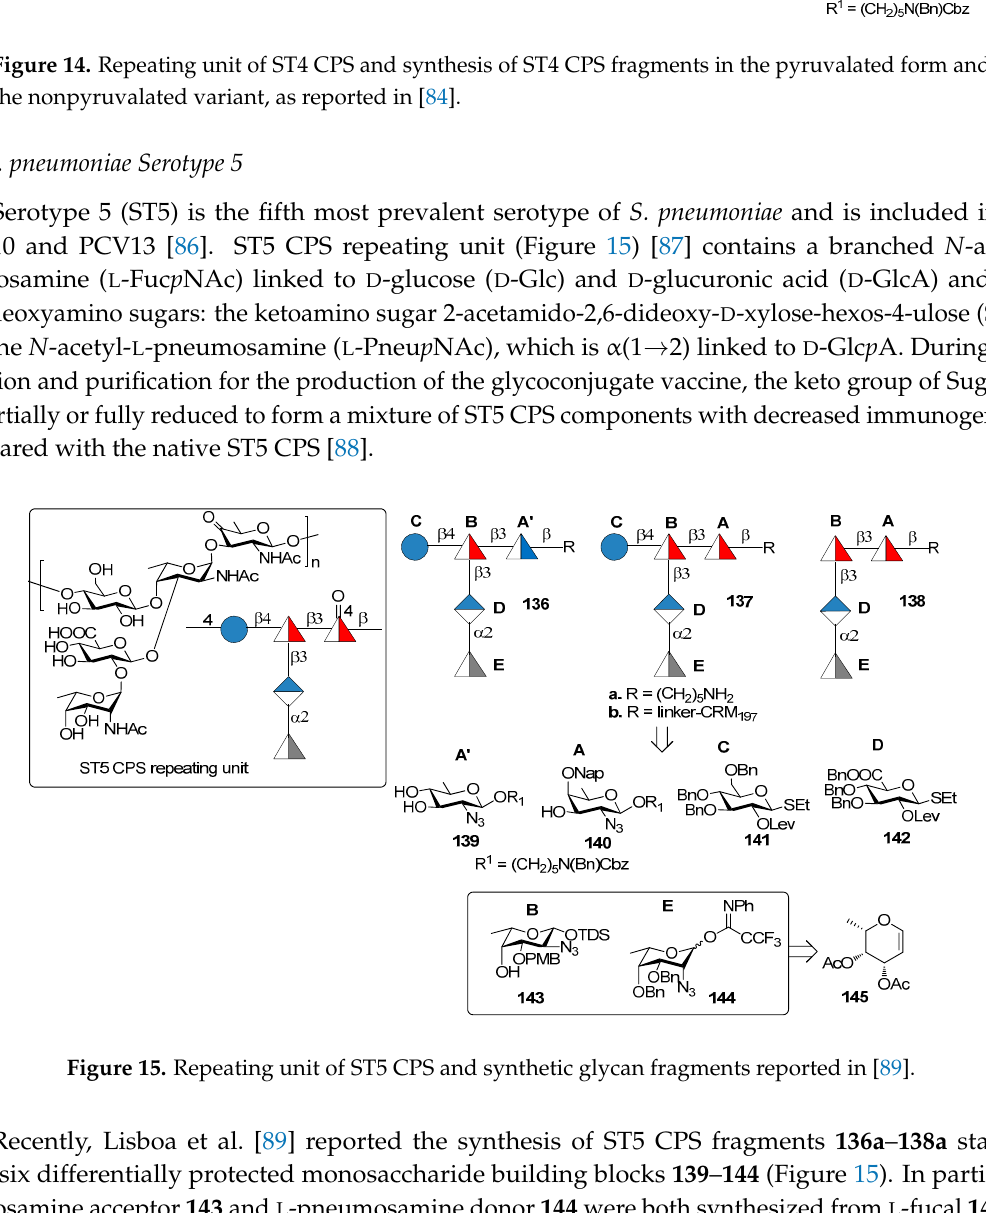
Figure 15. Repeating unit of ST5 CPS and synthetic glycan fragments reported in [89].